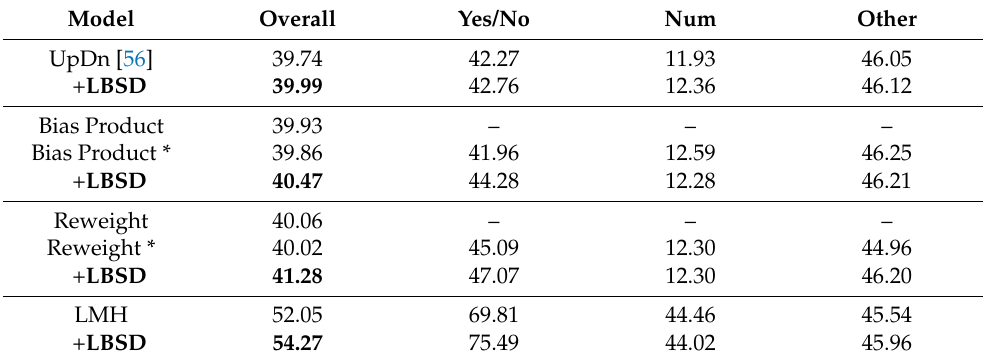
Table 2. VQA-CP v2: Ablation experiments of the LBSD method on the VQA-CP v2 dataset. * indi- cates the results from our reimplementation using officially released codes.